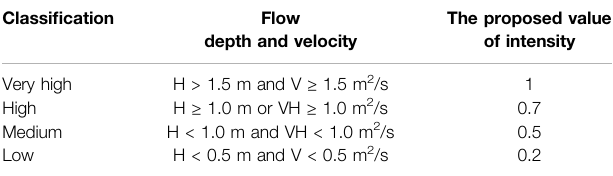
TABLE 1 | Classi fi cation of the intensity and proposed values. Classi fi cation Flow depth and velocity